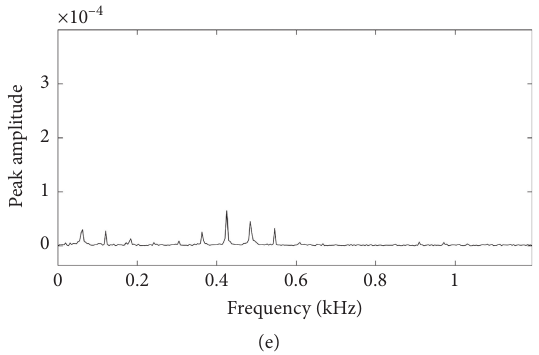
Figure 15: Envelope spectrum of signals before denoising. (a) Small defect, medium-high load, and 1500rpm. (b) Small defect, high load, and 600rpm. (c) Large defect, small load, and 1500rpm. (d) Large defect, medium-low load, and 1200rpm. (e) Large defect, high load, and 600rpm.